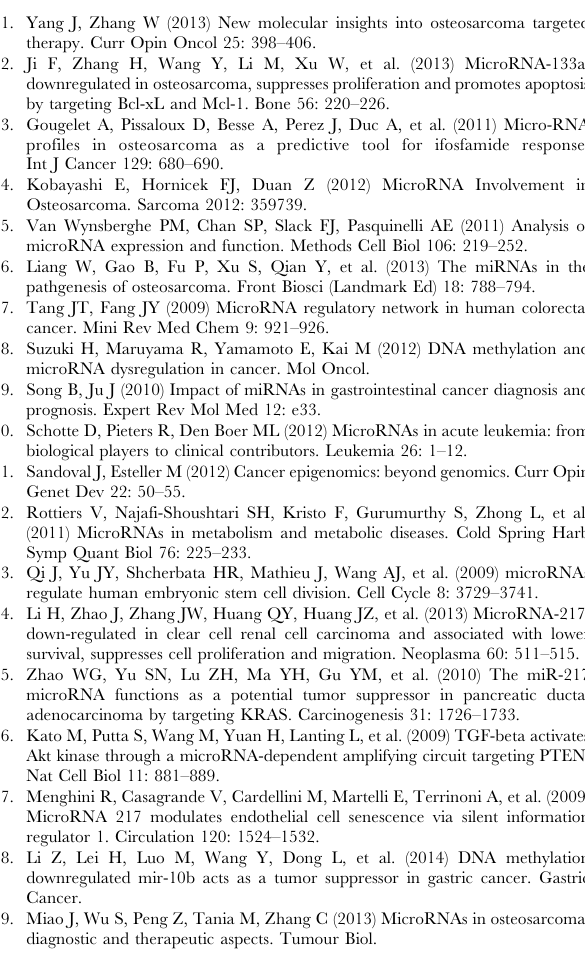
Table S1 Clinic pathologic charateristics of patients with osteosarcoma. Table S2 Primer